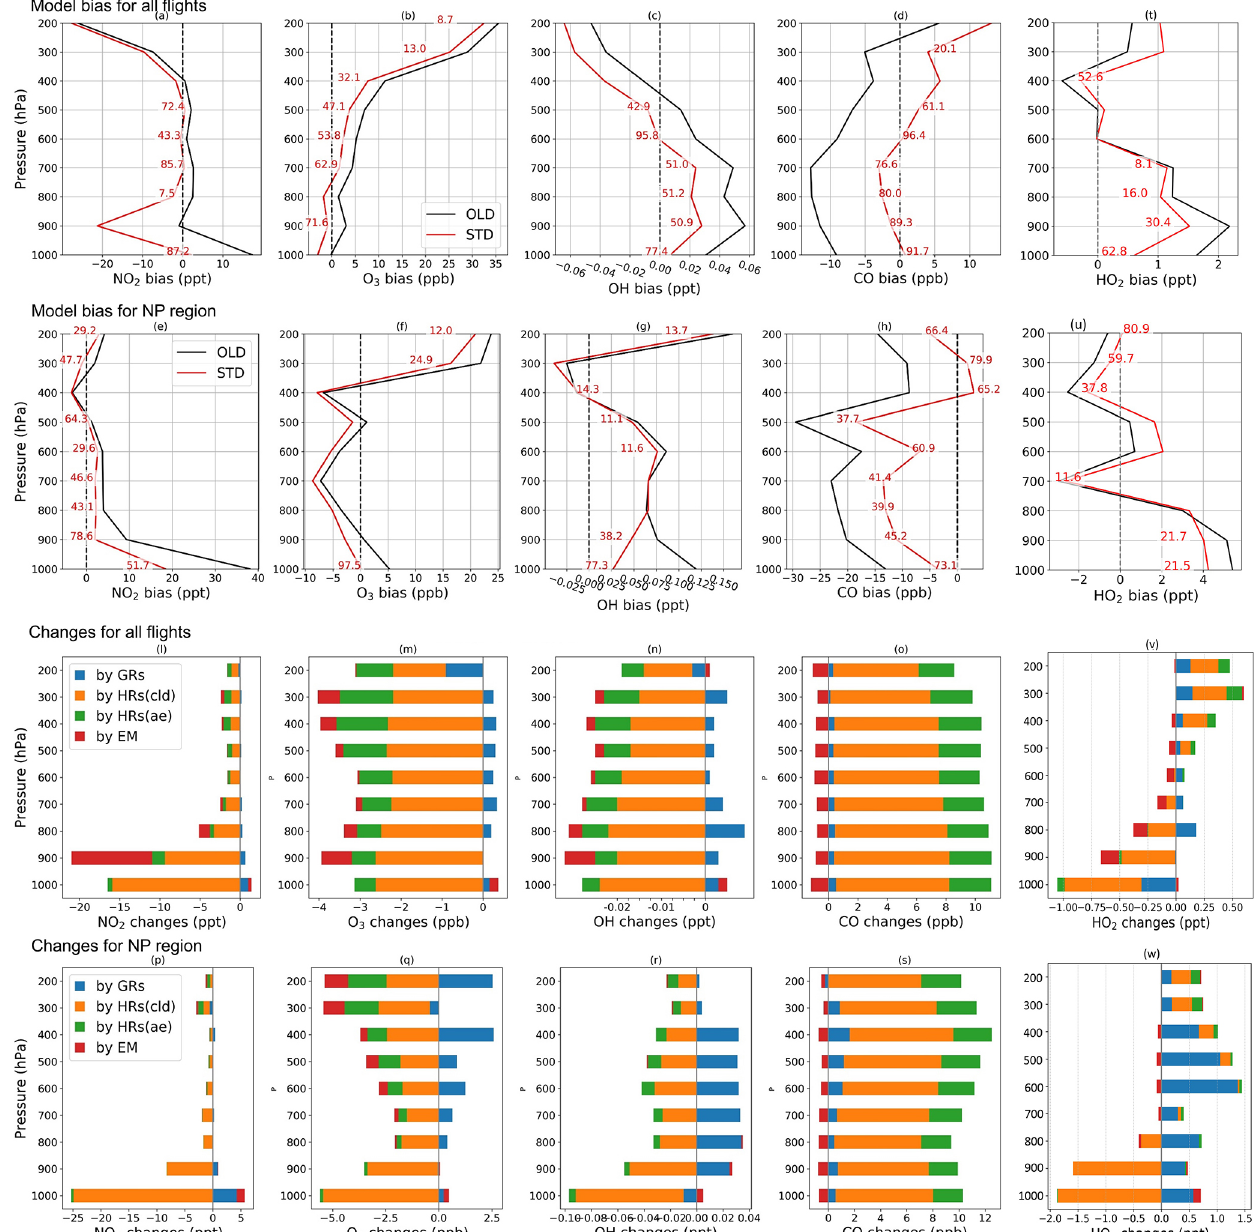
Figure 5. Vertical profile of model bias against aerial ATom-1 data (a–h, t–u) and changes by HONO chemistry (l–s, v–w) for NO 2 , O 3 , OH, CO, and HO 2 (from left to right columns). Biases in OLD (black lines) and STD (red lines) runs are calculated for all flights (a–d, t) and NP region (e–h, u) . The red numerical texts are the relative reductions (%) of the bias in the STD run compared to that in the OLD run. Changes by GRs (blue), HRs on clouds (orange), HRs on aerosols (green), and EM (red) are calculated for all flights (l–o, v) and NP region (p–s, w)